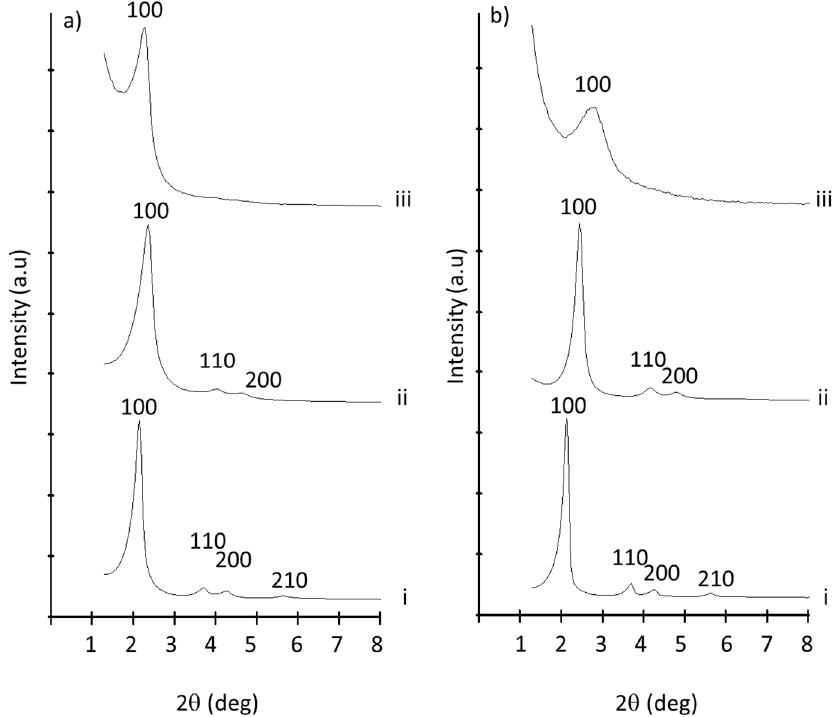
Figure 2. Powder X-ray diffraction of MCM-41 particles as prepared (i), after calcination (ii), and after the loading and functionalization process: ( a ) microparticles; ( b ) nanoparticles.